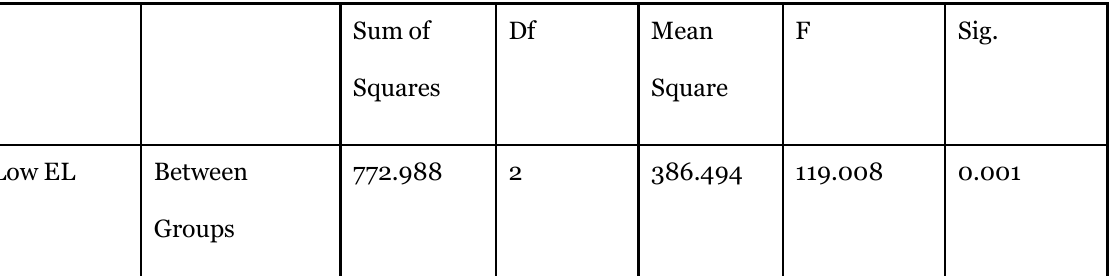
Table 5 ANOVA for the Different Effort Groups by Extraneous Load Group